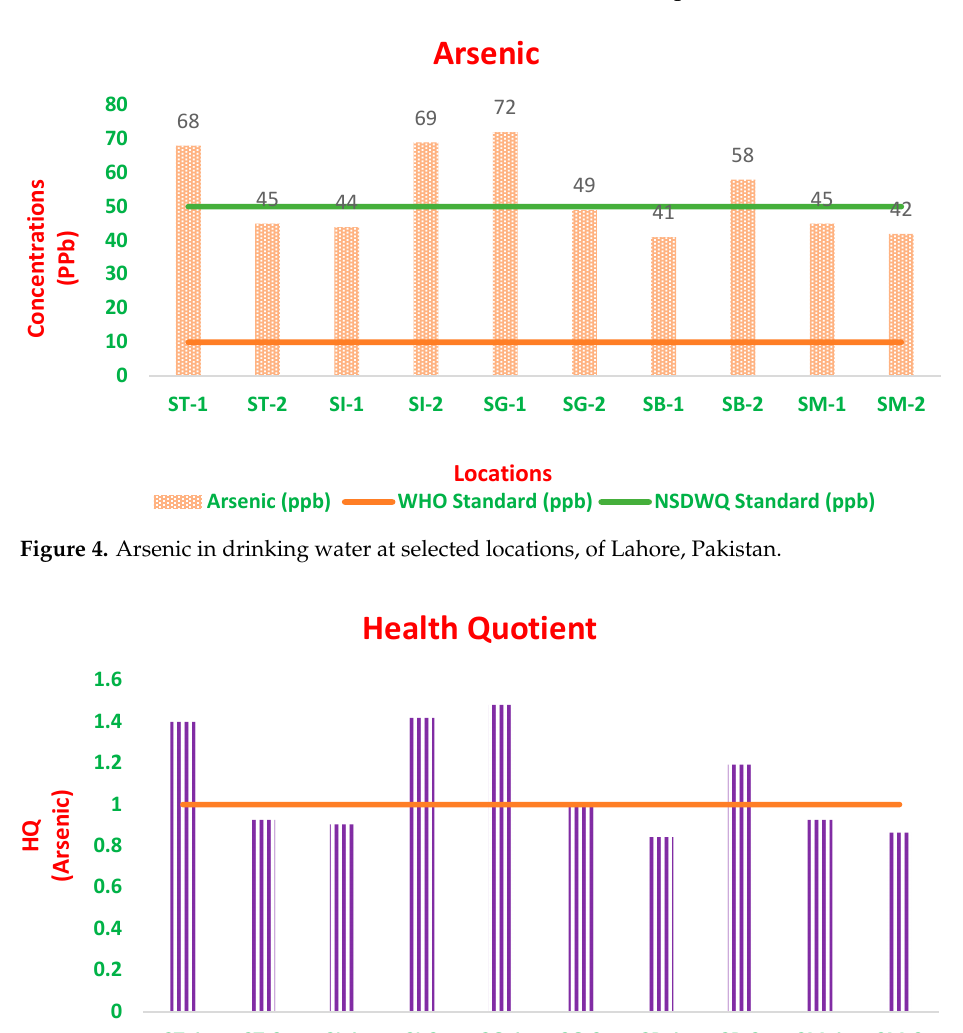
Figure 3. Faecal coliforms in drinking water at selected locations in Lahore, Pakistan.